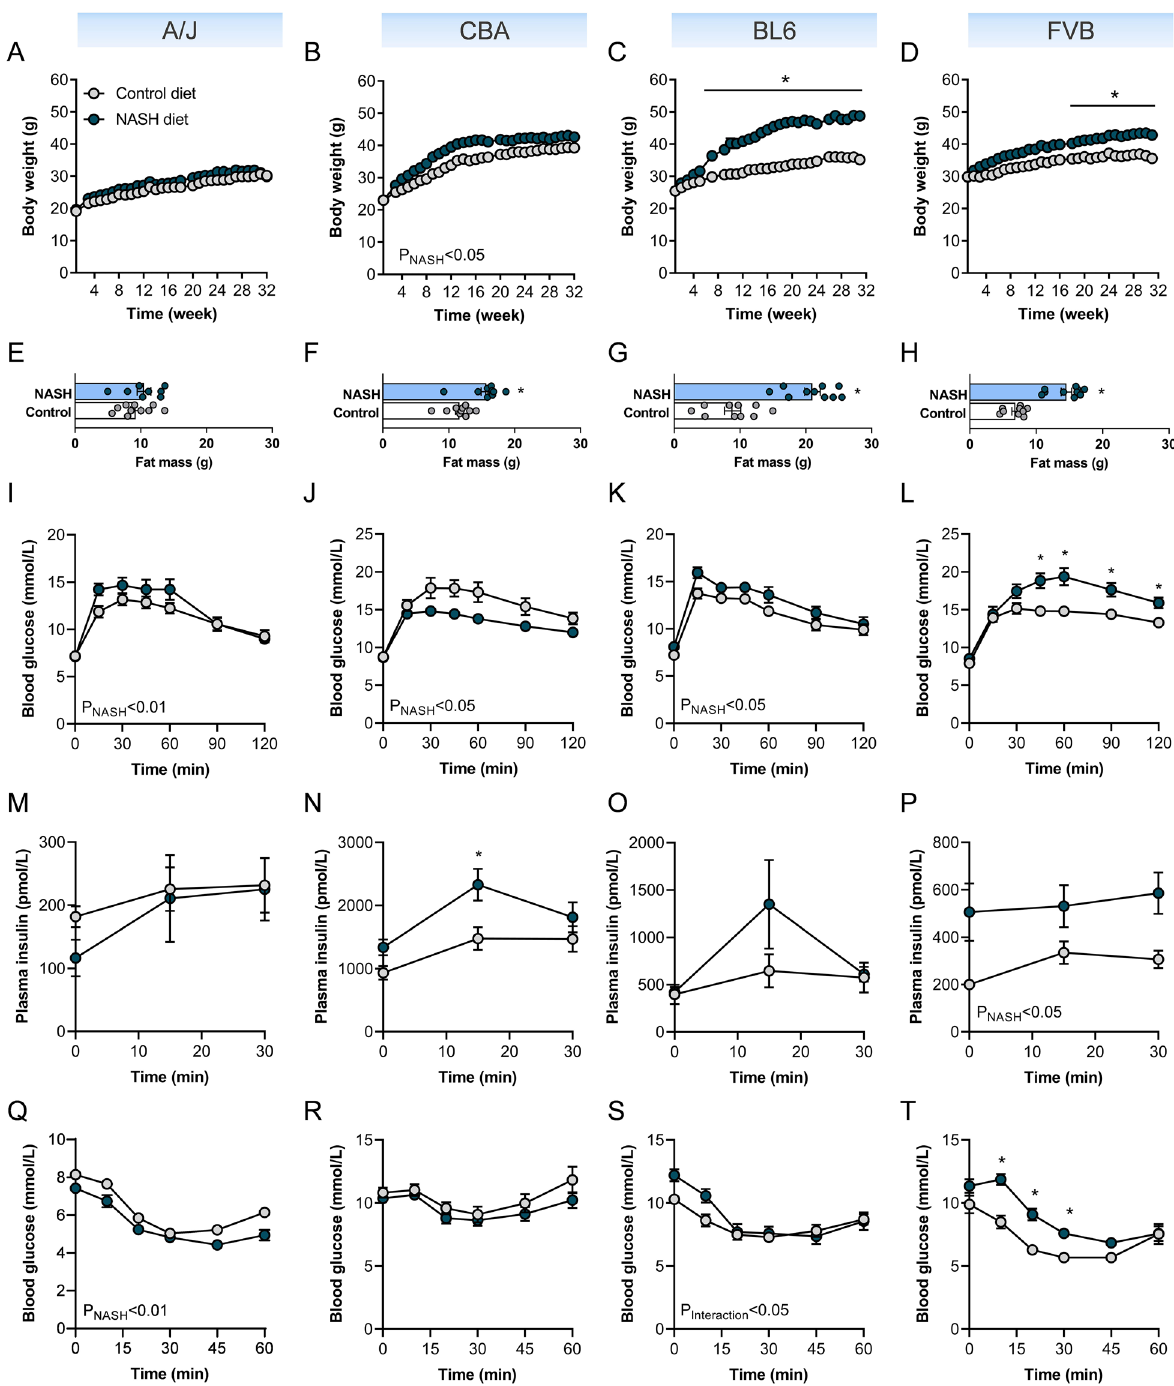
Figure 4. Metabolic phenotyping of NASH-susceptible mouse strains. Metabolic assessment is shown for the four NASH-susceptible mouse strains, including A/J, CBA/CaH, C57BL/6J and FVB/N, with mouse strains sorted by increasing prevalence of NASH and liver fibrosis (from left to right). ( A – D ) Weekly body weight (n = 8–10/group), ( E – H ) fat mass (n = 8–11/group), ( I – L ) glucose tolerance (n = 8–10/group), ( M – P ) plasma insulin assessed during the glucose tolerance test (n = 8–10/group), and ( Q – T ) insulin tolerance (n = 8–10/ group). Data are means ± SEM, *p < 0.05 vs. respective controls, as assessed by two-way unpaired t-test ( E – H ), or two-way ANOVA and Bonferroni post-hoc analysis ( A – D , M – T